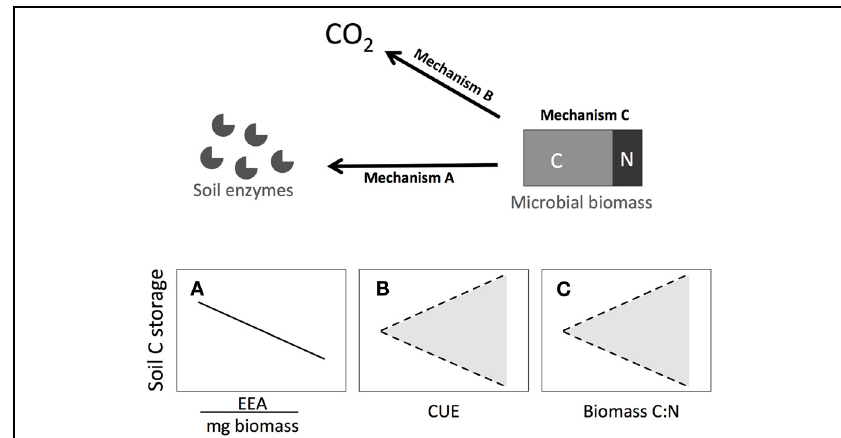
FIGURE 1 | Three mechanisms through which microorganisms can shift C allocation: (A) extracellular enzyme activities, (B) carbon use efficiency, or (C) biomass stoichiometry. Each of these pathways can alter C storage in soils. Trend lines indicate expected responses when each mechanism is operating in isolation. In (A) , increased C allocation to extracellular enzymes can decrease soil C storage by enhancing C cycling rates. Shading in (B and C) shows uncertainty owing to expected interactions between the total microbial biomass pool, CUE, biomass C:N and enzyme production. Increased CUE or biomass C:N can augment soil C storage by increasing the amount of C retained in the soil microbial biomass. Alternatively, increased C in microbial biomass may cause microbes to produce more enzymes per unit biomass to acquire limiting organic nutrients, ultimately decreasing soil C